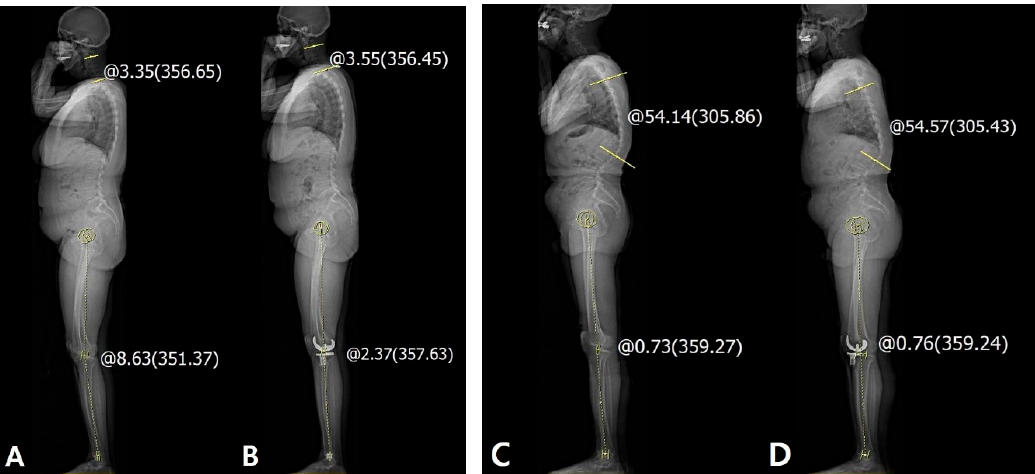
Figure 6. Cervical deformity showed little effect on the lower limb and spinal alignment itself. ( A ) Preoperative cervical lordosis: 3.35° and HKA angle: 8.63°. ( B ) Postoperative cervical lordosis: 3.55° and HKA angle: 2.37°. Thoracic deformity showed little effect on the lower limb and spinal alignment itself. ( C ) Preoperative thoracic kyphosis: 54.14° and HKA angle: 0.73°. ( D ) Postoperative thoracic kyphosis: 54.57° and HKA angle: 0.76°. The yellow line and circle are the measurement about sagittal HKA and cervical lordosis and thoracic kyphosis.